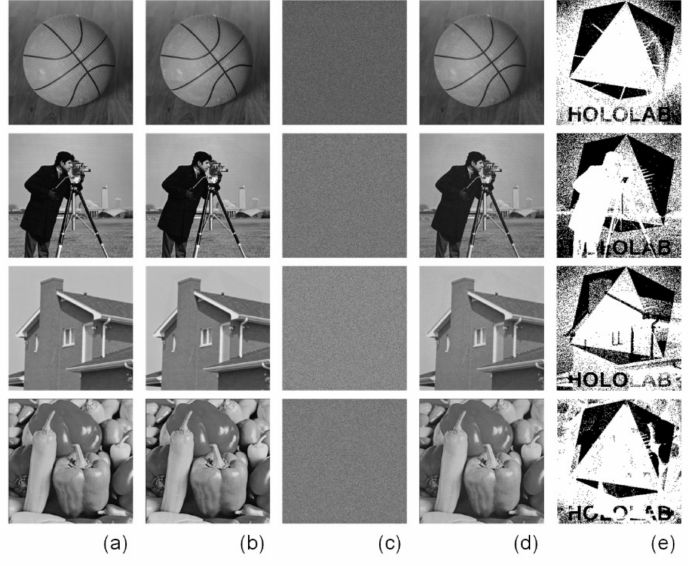
Figure 6. ( a ) The original images with a resolution of 2000 × 2000 pixels. ( b ) The watermarked images. ( c ) The reconstructions of encrypted CGHs. ( d ) The reconstructions of decrypted CGHs. ( e ) The extracted watermarks from the